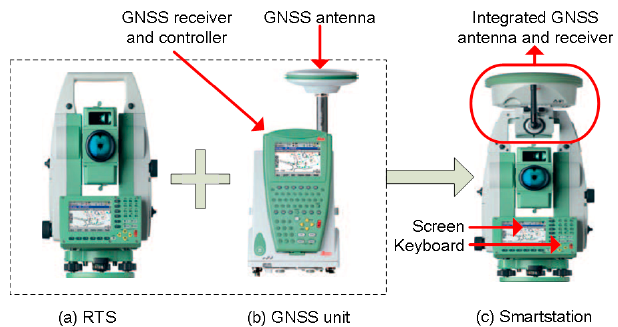
Figure 1. The composite instrument of the smartstation. The composite instrument combines a high-performance Leica TS30 robotic total station (RTS) ( a ), a powerful Leica GNSS unit ( b ) in one instrument and integrated GNSS antenna and receiver ( c ).